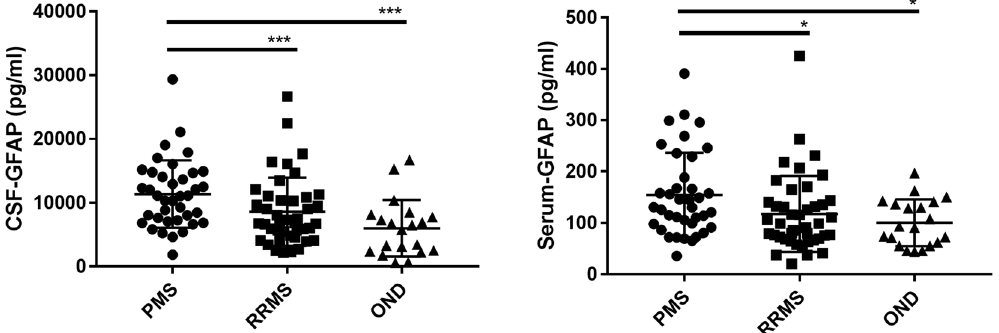
Figure 1. GFAP CSF and serum levels in multiple sclerosis patients and patients with other non-inflammatory neurological diseases (OND). GFAP: glial fibrillary acidic protein. CSF: cerebrospinal fluid, PMS: